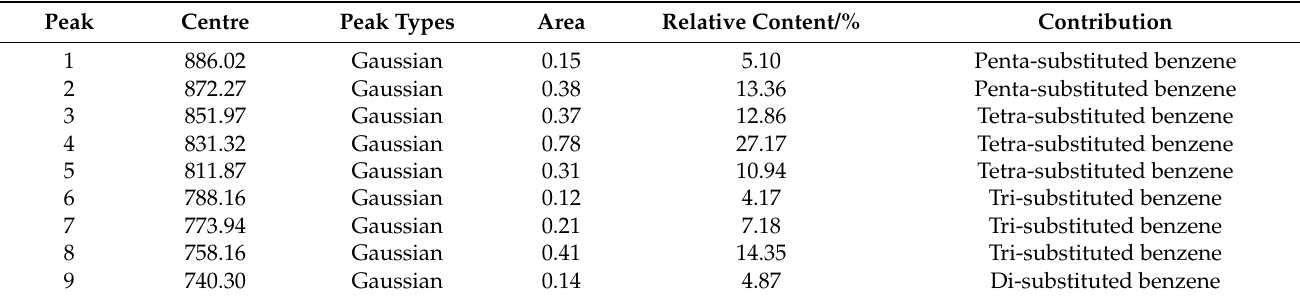
Table 11. Aromatic structural parameters of Kerjian